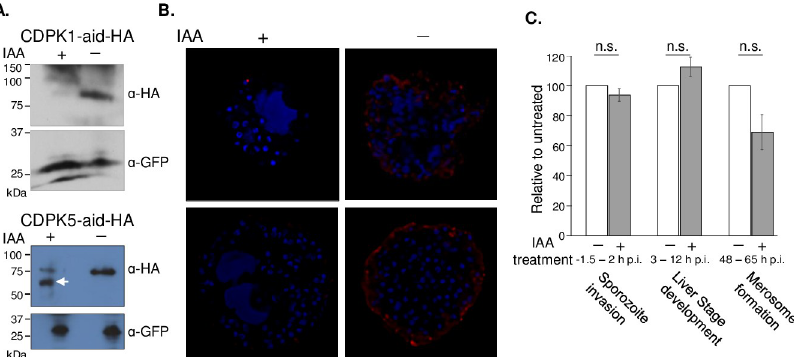
Fig 4. Conditional degradation of AID-tagged proteins is efficient in pre-erythrocytic stages. A) Western blot analysis of protein lysates from CDPK1-aid-HA and CDPK5-aid-HA parasites treated with IAA or vehicle. CDPK1-aid-HA and CDPK5-aid-HA were detected using an anti-HA antibody. GFP was used as a loading control. CDPK1-aid-HA and CDPK5-aid-HA have predicted molecular weights of approximately 90 kDa. The arrowhead indicates a byproduct of partial degradation of CDPK5-aid-HA. B) Depletion of CDPK5-aid-HA protein in merosomes was examined using immunofluorescence. Optical sections of representative IAA- or vehicle-treated merosomes immunostained with an anti-HA antibody. Parasite nuclei were visualized using DAPI. C) Effects of IAA treatment on Ostir1 pre-erythrocytic stages were examined by quantifying sporozoite invasion of HepG2 cells, the number of liver stages detected at 48 h p.i. and the number of merosomes released into the media at 66–70 h p.i., in the presence or absence of IAA. Results shown are average of 2–4 experiments with 3 technical replicates ( ± SEM), normalized to vehicle-treated samples for each assay. Data were analyzed using an unpaired t -test, not significant (n.s.) P value >